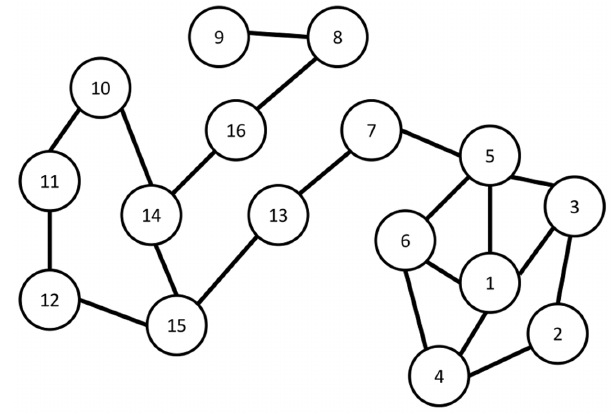
Figure 1. An Example Network. N 12 ~ 5 , N 11 ~ 4 , and N 15 ~ 7 . C L (1) ~ 77, C L (2) ~ 35 , and C L (10) ~ 27 . C LC (1,2) ~ 77, C LC (1,10) ~ 104 . Note that although the local-centrality for node 2 is higher than that of 10, the combinatorial local centrality is higher when nodes 1 and 10 are paired, rather than 1 and 2.